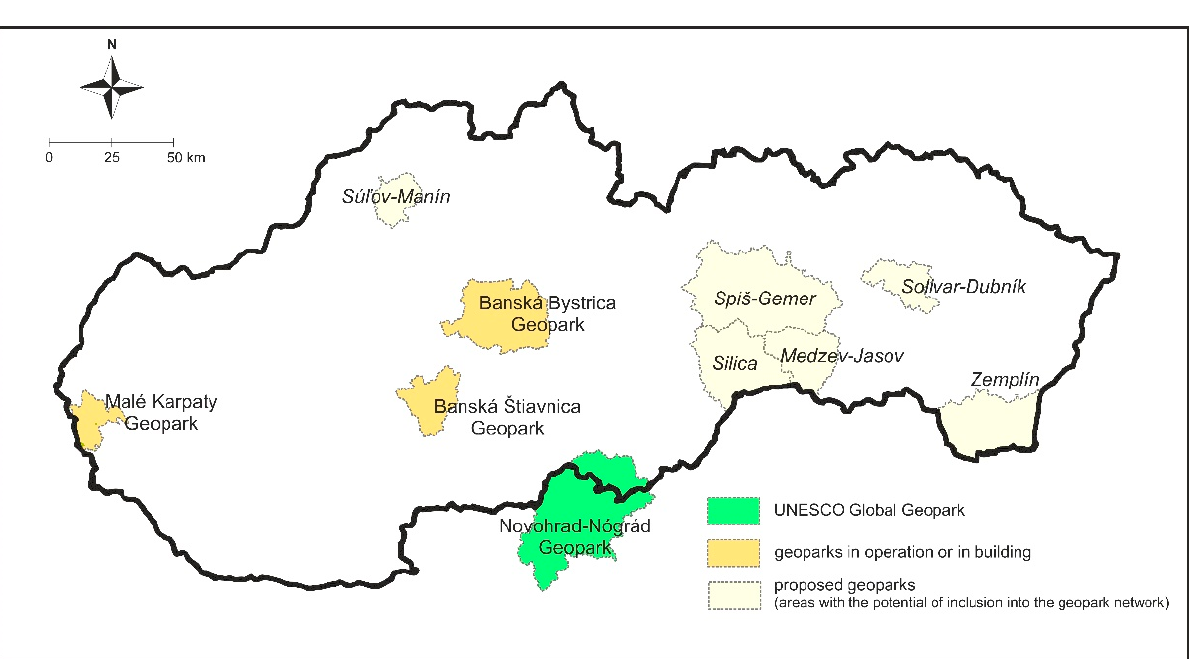
Figure 3. Location of geoparks and areas with the potential of geopark establishment in Slovakia [43,44]. Table 2. Types and numbers of sites in Slovak geoparks as identified by geopark operators [45].